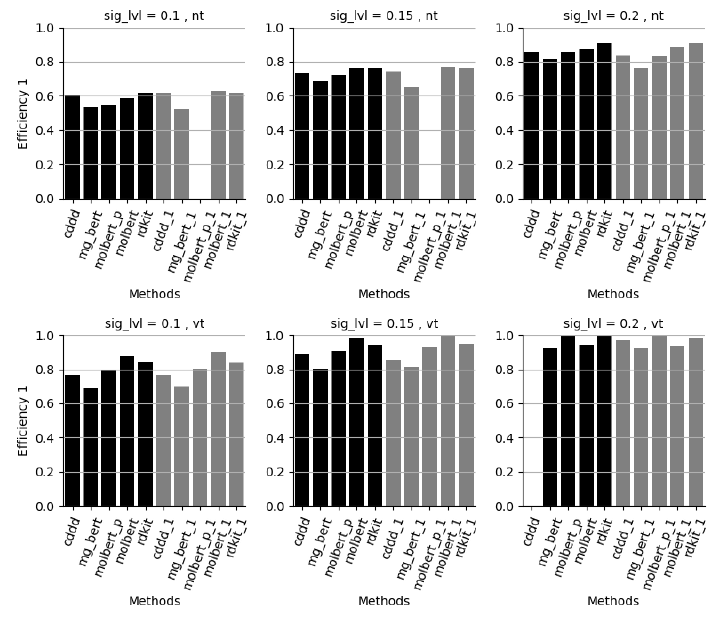
Figure 4. Evaluation set efficiency for class “1” for the 2 datasets (NT model upper row, VT model lower row), at significance levels 0.1–0.2, for each method. Class “1”: non-toxic class and very toxic class for the 2 datasets nt and vt, respectively. Methods: cddd = RF/cddd 10